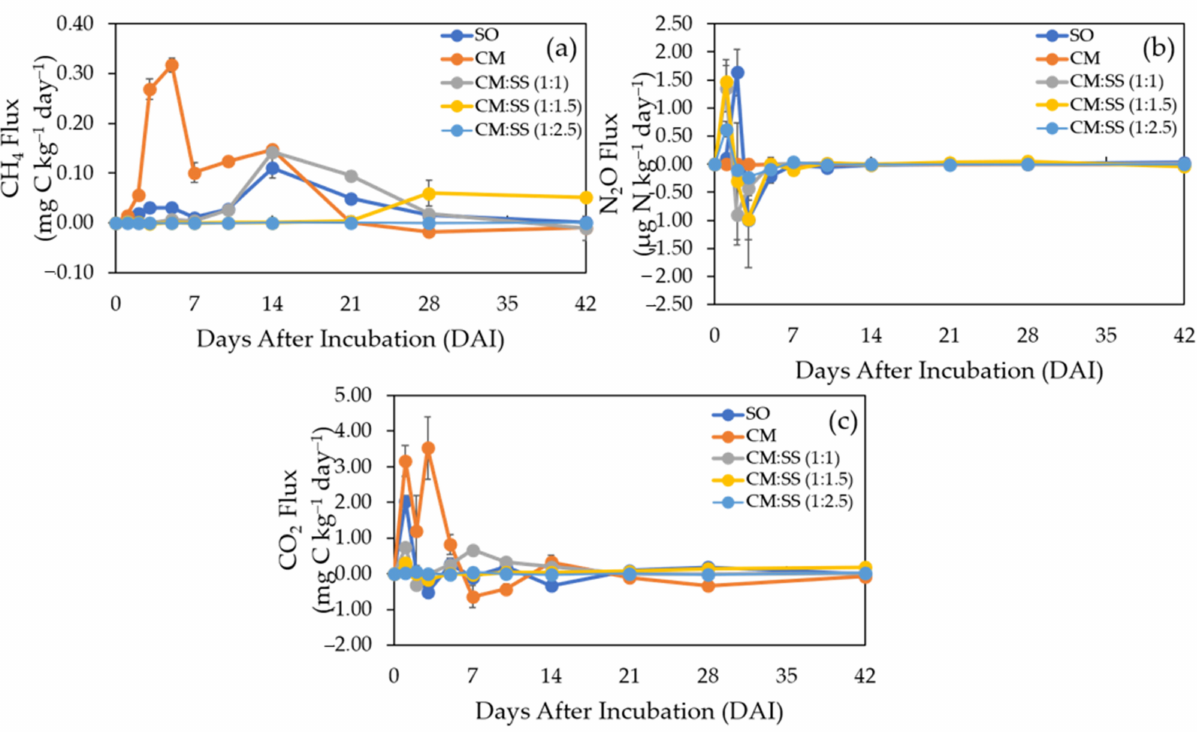
Figure 1. CH 4 ( a ), N 2 O ( b ), and CO 2 ( c ) flux during the incubation experiment. SO: soil only, CM: chicken manure, SS: steel slag. CM:SS is the weight given ratio between chicken manure and steel slag. Error bars represent standard